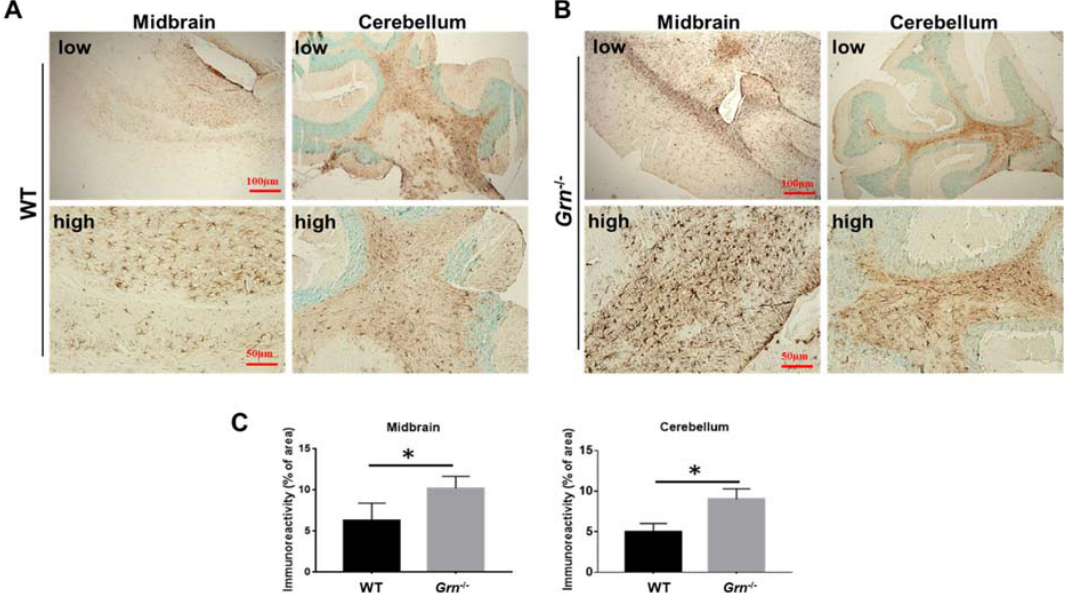
Figure 3. Ablation of PGRN promoted the activation of astrocytes in aged mice. Brain sections from 12 ‐ month ‐ old WT and Grn − /– mice were stained with anti ‐ GFAP antibody. The accumulation of GFAP ‐ positive cells was analyzed in two different brain regions, midbrain and cerebellum, using immunohistochemistry. ( A , B ) Representative images of three different brain regions from three independent WT mice or Grn − /– mice. ( C ) Statistical analysis of A and B. n = 3. Data presented as mean ± SD. * p < 0.05.